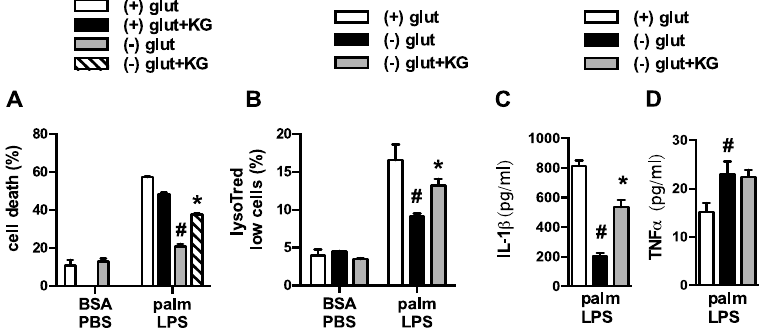
Figure 3. α‐ ketoglutarate partially restores macrophage lipotoxic phenotypes under glutamine deficient conditions. ( A ) Macrophages were treated as indicated in glutamine sufficient and deficient media ± 440 nM α‐ ketoglutarate ( α‐ KG) and cell death ( A ) or lysotracker low cells ( B ) were quantified by flow cytometry; ( C , D ) pMACs were stimulated with palm ‐ LPS in glutamine sufficient and deficient media ± α‐ KG and IL ‐ 1 β ( C ) or TNF α ( D ) release was quantified by ELISA. Bar graphs report the mean ± SE for a minimum of 3 experiments, each performed in triplicate. * , p < 0.05 for veh vs . α‐ KG; #, p < 0.05 glutamine vs . no glutamine.